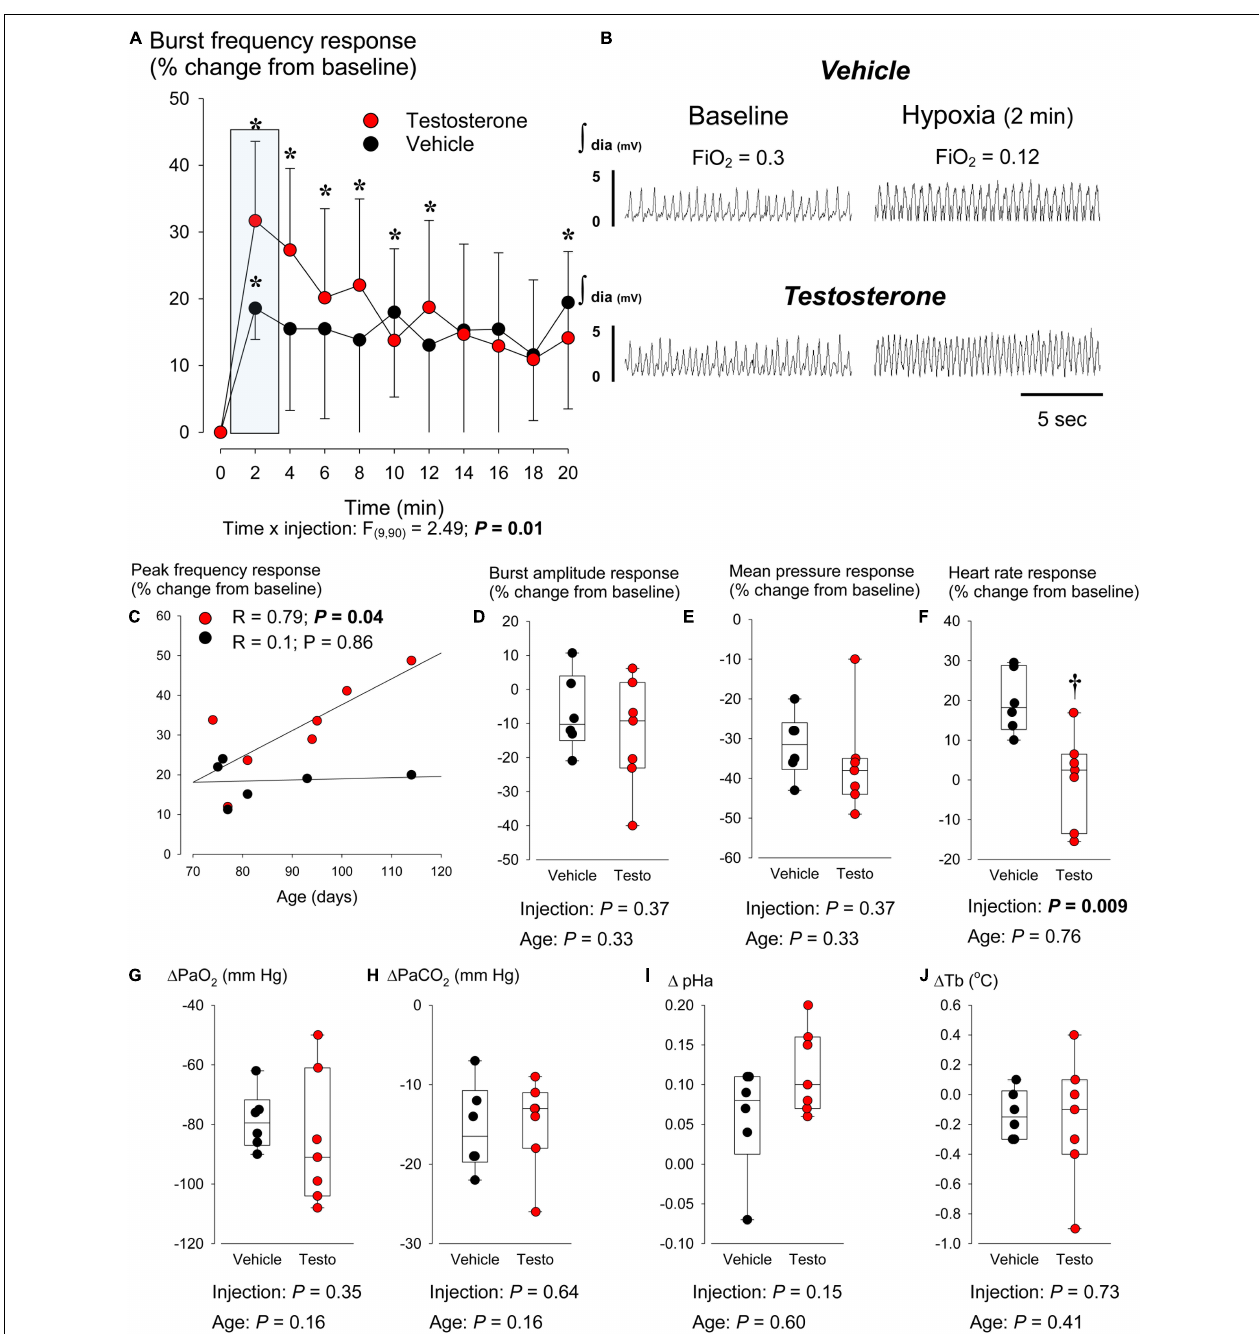
FIGURE 3 | Testosterone supplementation potentiates the acute hypoxic ventilatory response. (A) Comparison of the time course of the breathing frequency response to hypoxia between rats supplemented with testosterone propionate (red circles; 2 mg/kg; i.p.) or vehicle (black circles; benzyl benzoate + alcohol benzoate dissolved in cottonseed oil) 30 min prior to the onset moderate hypoxia (FiO 2 = 0.12; 20 min). The response is expressed as a percent change from baseline (FiO 2 = 0.30, balance N 2 ). Rats were anesthetized with urethane (1.4 g/kg; i.v.). Respiratory activity was measured by placing and electromyogram (EMG) electrode in the diaphragm. (B) Representative EMG recordings comparing inspiratory activity under baseline condition and 2 min after the onset of hypoxia between rats that received vehicle (top traces) and testosterone (bottom traces). (C) Correlation analysis of the relationship between the rat’s age (days) and the peak increase in breathing frequency in response to hypoxia (2 min). Correlations are compared between rats treated with vehicle (black circles) or testosterone (red circles). Box plots comparing (D) EMG amplitude, (E) mean arterial blood pressure, and (F) heart rate responses measured at the end of the hypoxic stimulus; these results are expressed as a percent change from baseline. Changes in (G) arterial PO 2 , (H) arterial PCO 2 , (I) arterial pH, and (J) body temperature relative to baseline; these results are expressed in absolute values. In each box plot, the boundary of the box closest to zero indicates the 25th percentile, the line within the box marks the median, and the boundary of the box farthest from zero indicates the 75th percentile. Whiskers (error bars) above and below the box indicate the 90th and 10th percentiles. * indicates value different from baseline at P < 0.05. † indicates a value different from vehicle at P < 0.05.